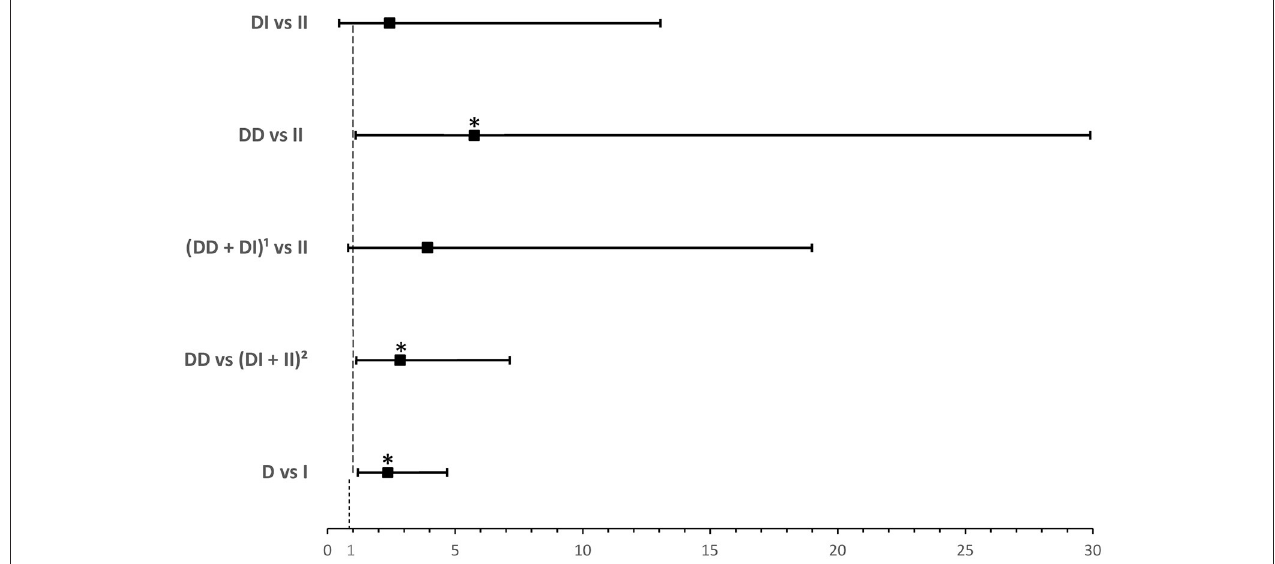
FIGURE 2 | Forest plot showing odds ratios ± 95% confidence intervals of ACE1 polymorphism for developing severe a disease in symptomatic COVID-19 cases. Multivariate analysis included variables that were statistically significant in the association analysis shown in Table 2 ; * P < 0.05. a Rated as mild, moderate, or severe according to WHO clinical progression scale for COVID-19 with mild disease as Reference. 1 D allele carriers. 2 I allele